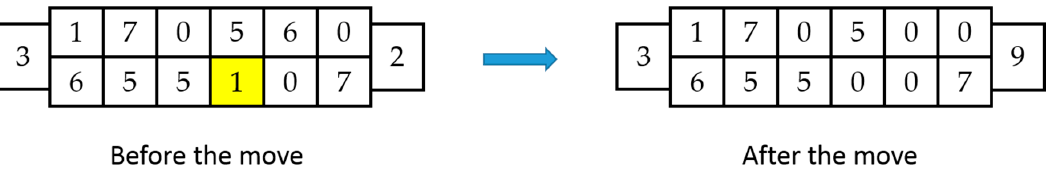
Figure 4. A move leading to an additional move. The selected pit to be sowed is highlighted in yellow.